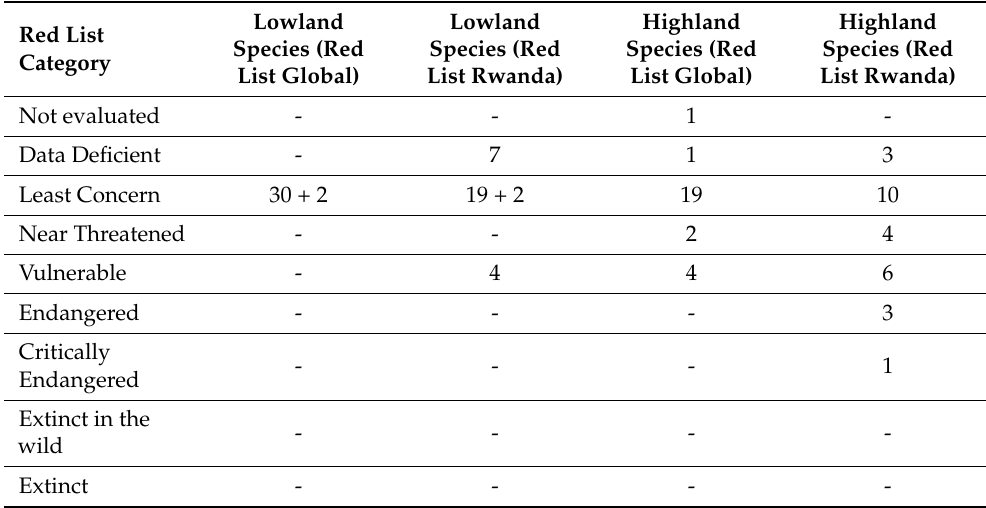
Table 3. Red List categories of the taxonomically described amphibian species occurring in Rwanda. Data are given separately for lowland (30 species + 2 shared highland species) and highland meta- communities (27 species). The IUCN assessment [7] is compared with our assessment of the national conservation status of these species in